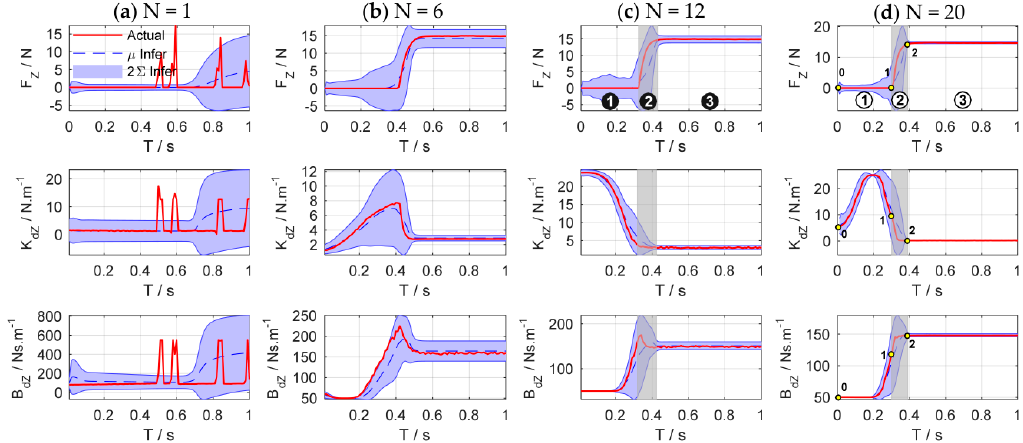
Figure 11. States evolution of force control. Columns ( a – d ) are the state evolutions of the 1st, 6th, 12th, and 20th learning iteration, respectively. The top row is the change of contact force F z , the second row is the target stiffness K dz , and the third row is the target damping B dz